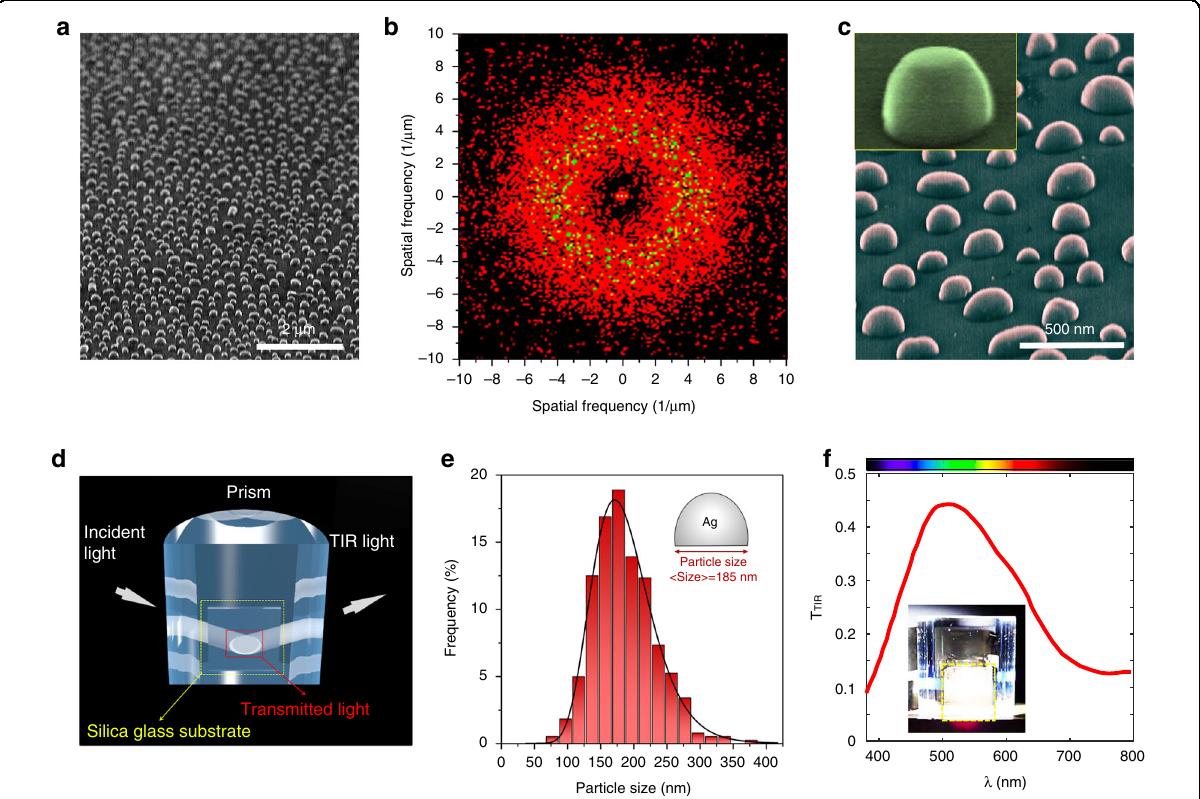
Fig. 3 Characterisations of the fabricated disordered metasurface Meat-IV. a Low magni fi cation SEM image of the disordered Ag metasurface. b Two-dimensional Fourier power spectrum of the position of the Ag nanostructures, which is calculated from the SEM image of disordered Ag metasurface. c The tilted view of the disordered metasurfaces with high magni fi cation. Inset is image of a single Ag nanostructure. d A schematic illustration of the light extraction measurement setup. e Size distribution histogram of the Ag nanoparticles in the optimised disordered metasurface and corresponding Log-Normal fi tting (black solid line). f Transmission spectrum from the hemispherical glass prisms with Meta-IV for θ i = 50 o . The SiO 2 substrate covered with disordered Ag metasurface and the prism were bonded together by using index-matching fl uid ( n = 1.46). Inset: optical image of the spot of transmitted light extracted from the glass prism with disordered Ag